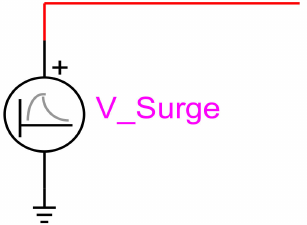
Figure 1. Voltage surge device to generate indirect lightning impulses.